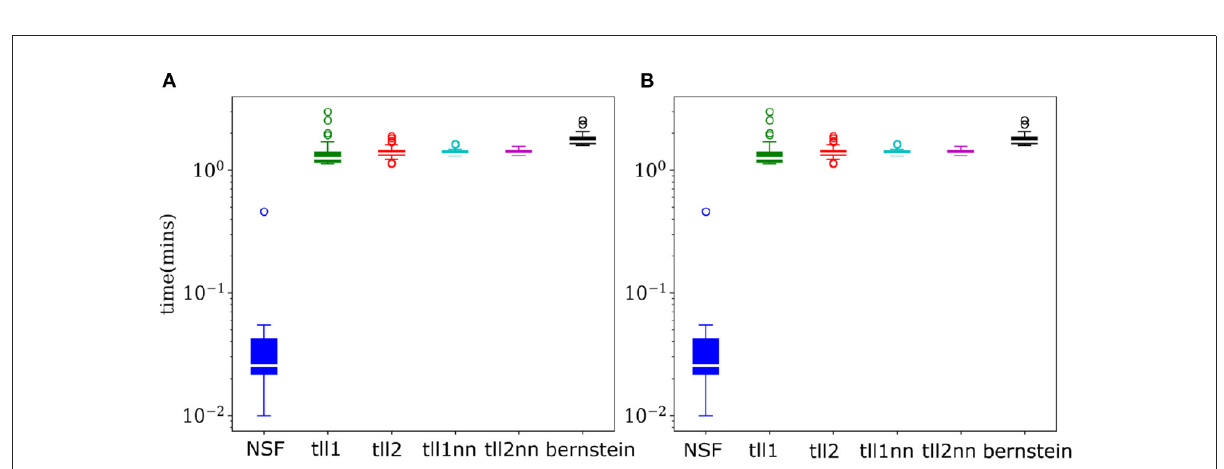
FIGURE4 NSFs vastly outperform other non-parametric estimators on sampling. (A) Boxplots of time (mins) required to sample from trained NSF compared to the other non-parametric estimators. The vertical axis is plotted on logarithmic scale. (B) Boxplots of time (min) required to estimate copula entropy from the trained NSF compared to the other non-parametric